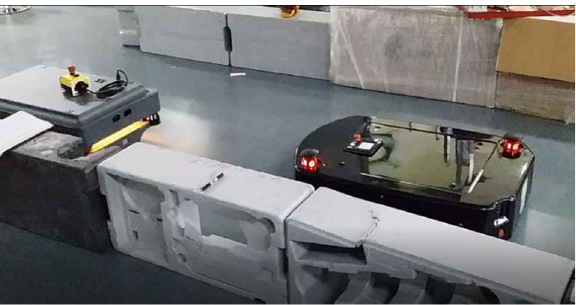
Figure 17. Environment of the field experiment. The field experiment parameters are as follows. Table 8. Run time and path length for five rounds of path